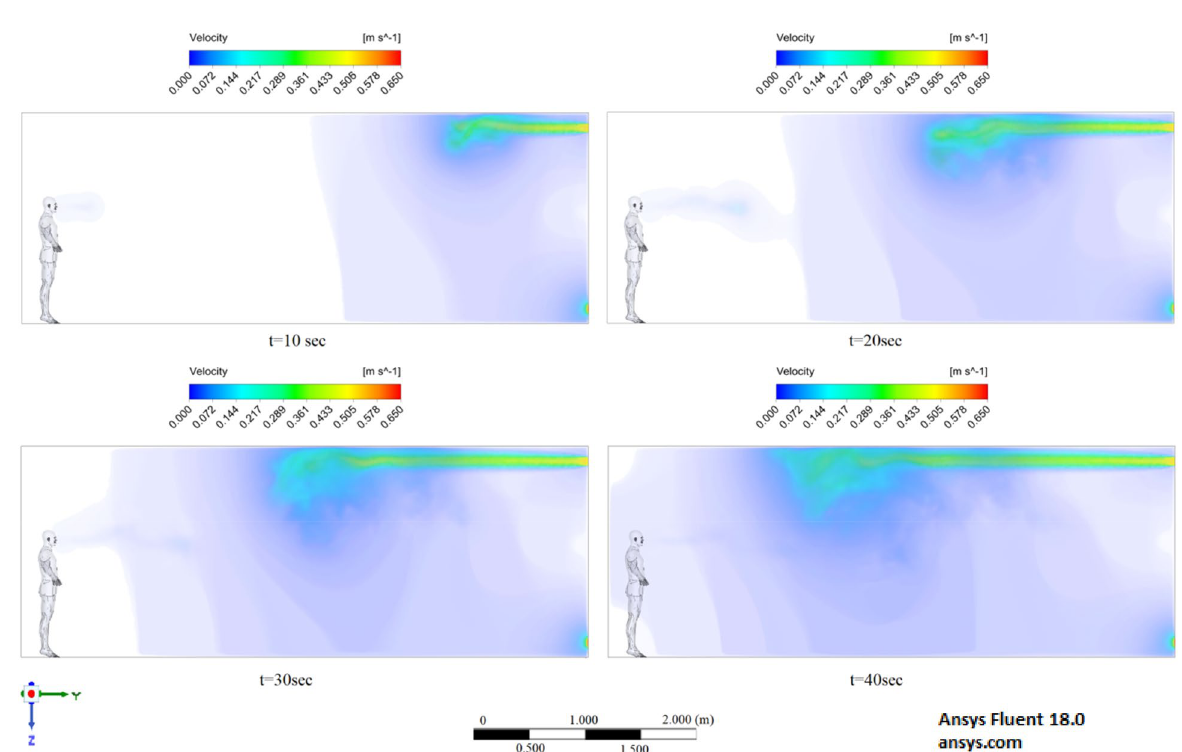
Figure 13. Velocity contours for cough = 6 m/s and ventilation = 0.5